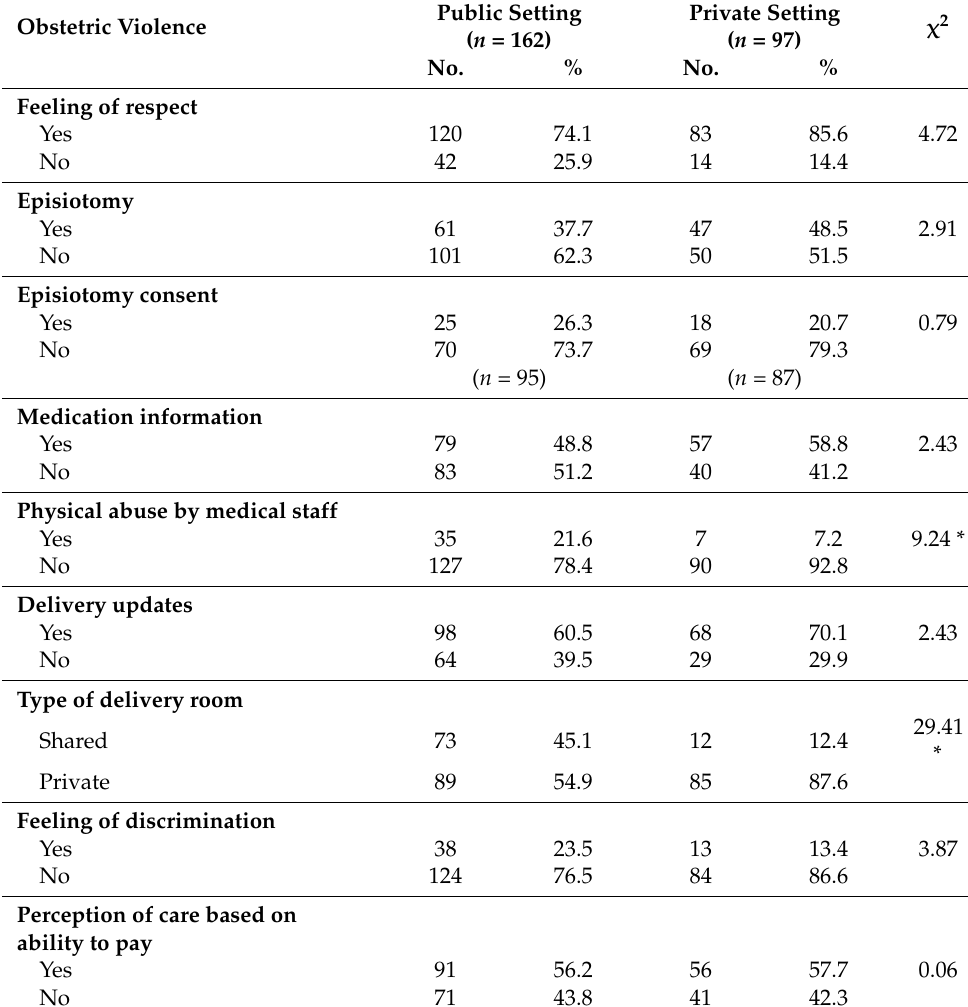
Table 2. Obstetric violence in public and private settings (Amman, 2022). Obstetric Violence